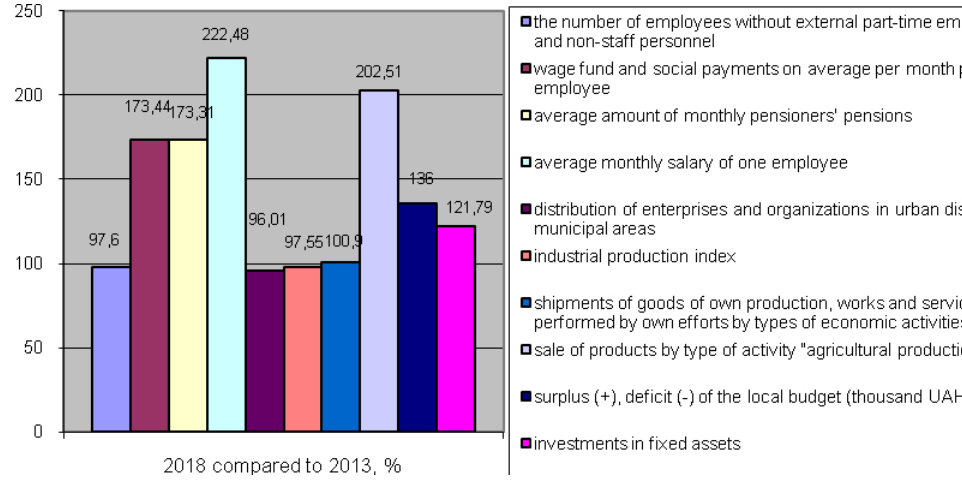
Fig. 2: Dynamics of economic indicators of rural areas of Vinnitsa region